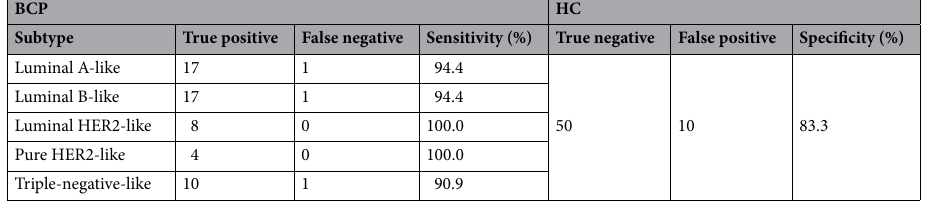
Table 3. The results for each histological subtype when applying the model to the training set. BCP breast cancer patients, HC healthy controls.